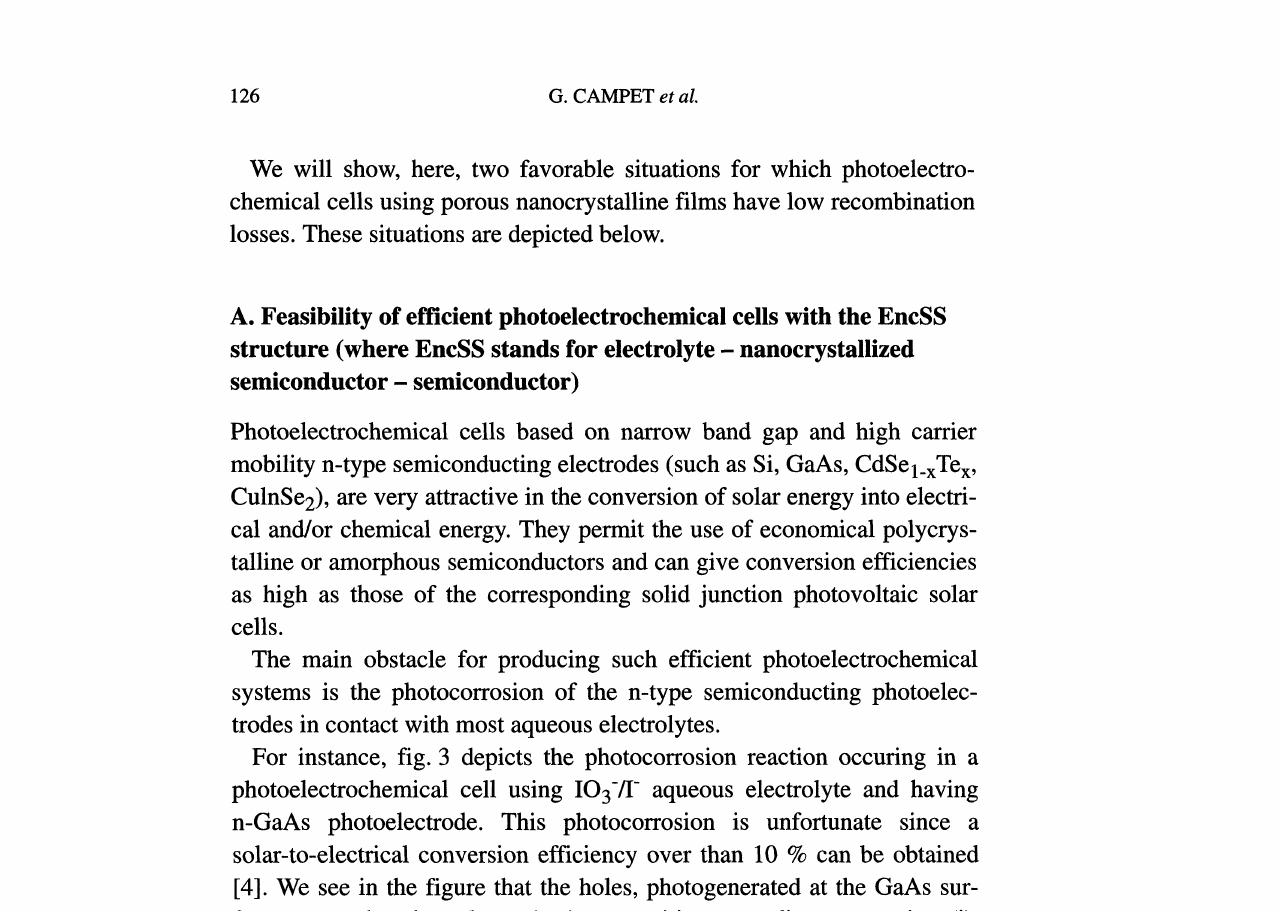
FIGURE 3 Photocorrosion reaction occuring in a photoelectrochemical cell having n-GaAs photoelectrode (electrolyte: 0.1M I-/103 + 0.1M